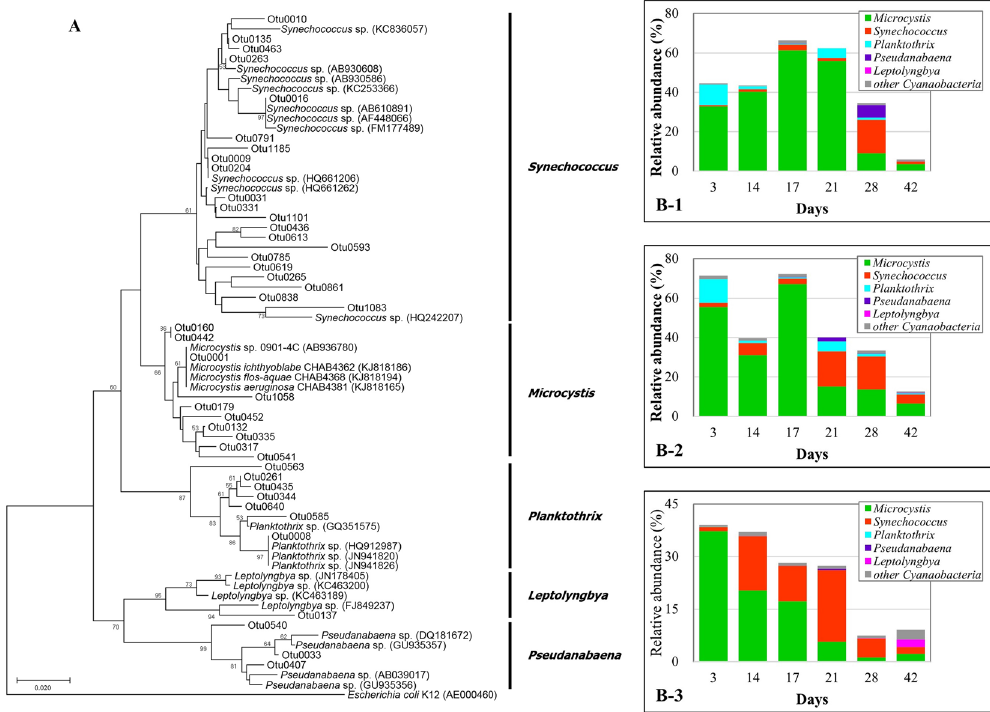
Figure 6. 16S rRNA phylogenetic tree of Cyanobacteria phylum and the proportions of each assigned genus in the total bacterial communities. Neighbor-joining 16S rRNA phylogenetic tree ( A ) of Cyanobacteria phylum. OTUs (relative abundance more than 0.1%) were separated into five different genera: Microcystis , Synechococcus , Planktothrix , Pseudanabaena and Leptolyngbya . Bootstrap values (expressed as percentages of 1000 replications) > 50% are shown at the branch point. Bar, 0.02 substitutions per nucleotide position. The proportions of genera mentioned above in the Control (B-1), T-PL (B-2) and T-PP (B-3) samples are listed in this